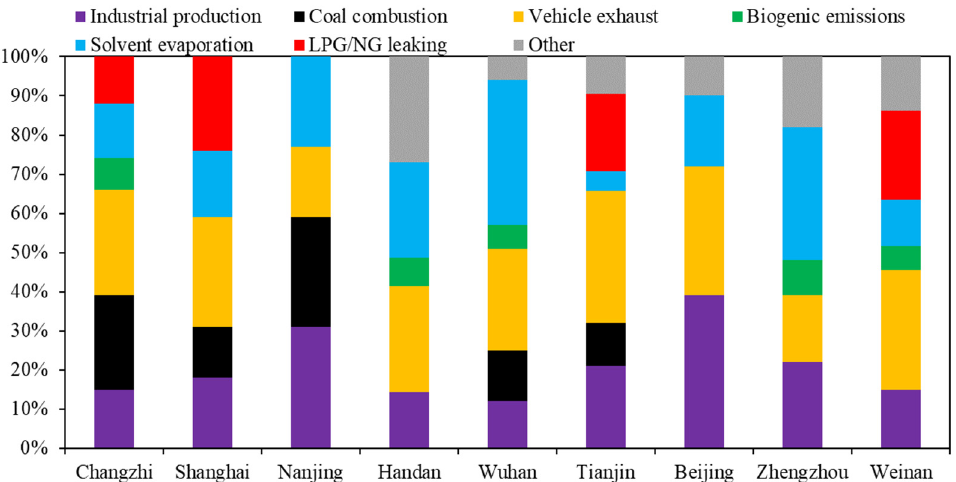
Figure 4. Contribution of each VOC sources in different cities.